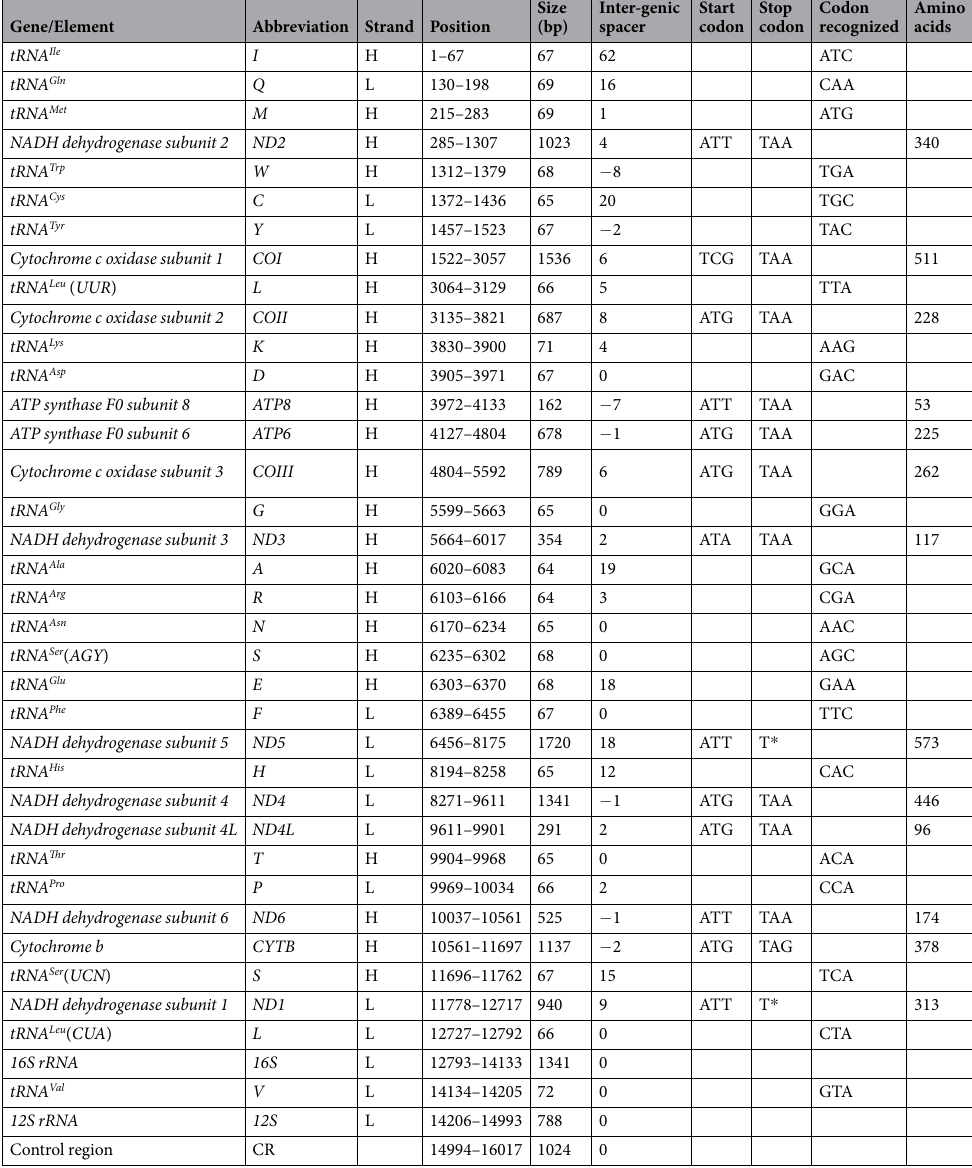
Table 2. Organization of the Ceratitis fasciventris mitochondrial genome. * TAA stop codon is completed by the addition of 3 ′ A residues to